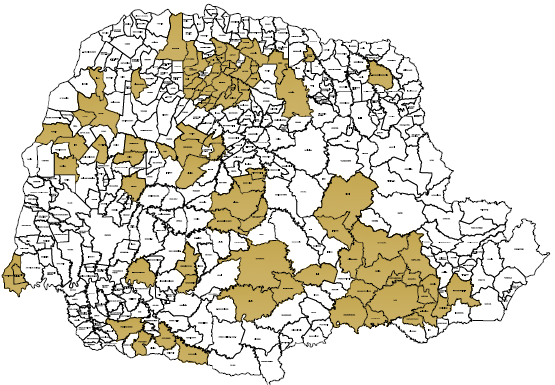
Figure 4. Municipalities with agricultural areas that received sewage sludge, from 20017 to 2017, in Paraná State.